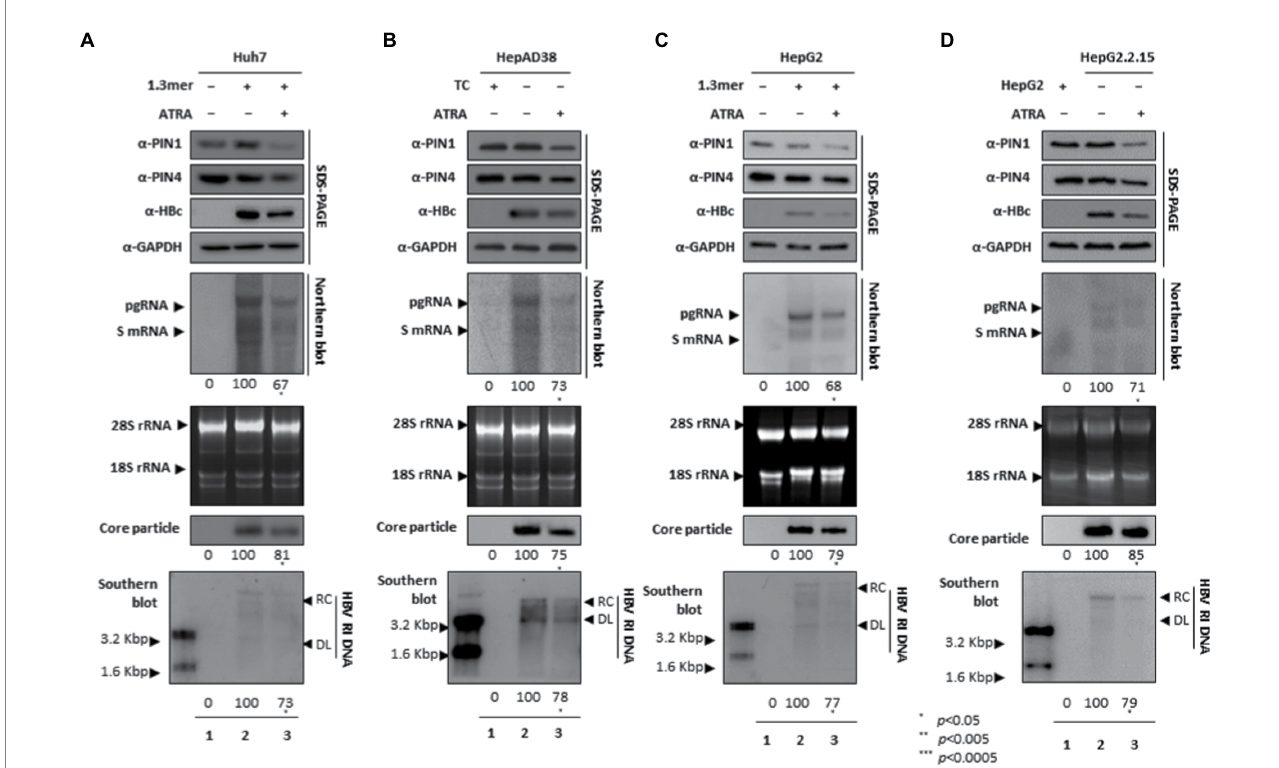
FIGURE 5 PIN1 and PIN4 inhibition via ATRA abrogate HBV replication in Huh7, HepAD38, HepG2, and HepG2.2.15. (A–D) ATRA reduces HBV replication. (A) The Huh7 cells were mock-transfected (lane 1), transfected with 4 μ g of 1.3 mer HBV WT and treated with DMSO (lane 2), or transfected by 1.3 mer HBV WT (4 μ g) and treated with 30 μ M of ATRA for 72 h (lane 3). (B) HepAD38 was treated with mock (none, lane 1) or DMSO (lane 2), or treated with 30 μ M ATRA (lane 3) for 72 h. (C) HepG2 cells were transfected with mock (lane 1), 1.3 mer HBV WT (4 μ g) transfected and treated with DMSO (lane 2), or 4 μ g 1.3 mer HBV WT transfected and treated with ATRA (30 μ M) for 72 h (lane 3). (D) HepG2.2.15 cells were treated with DMSO (lane 2) or ATRA (30 μ M) treated for 72 h (lane 3). Lane 1 indicates mock-transfected HepG2 cells (negative control). The lysates were subjected to SDS-PAGE and immunoblotting, NAGE, Northern, and Southern blotting. The presented data are representative of three independent experiments. The statistical analysis was determined using Student’s t -test. * p < 0.05, ** p < 0.005, *** p < 0.0005 relative to the